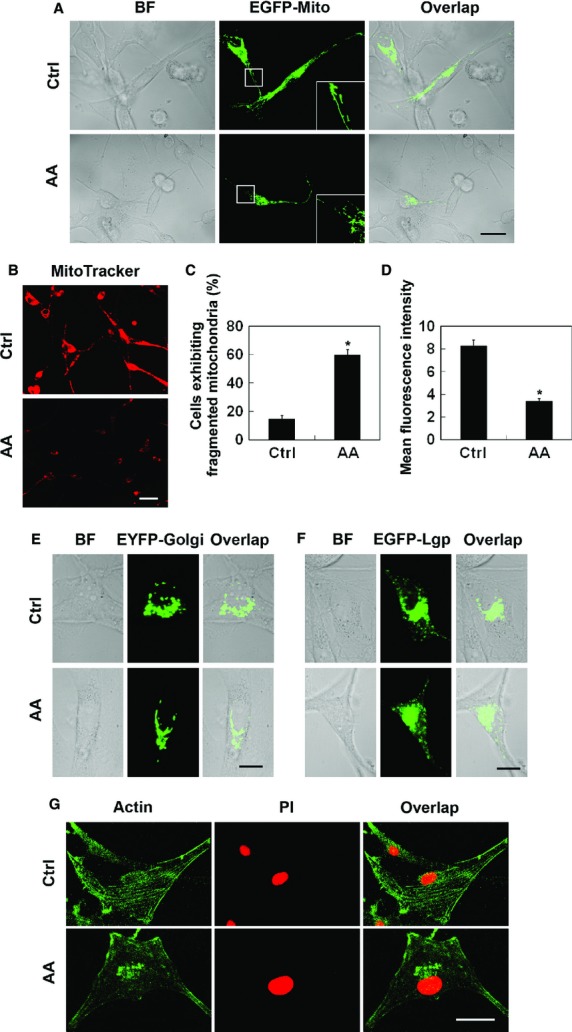
Influence of aurantiamide acetate on intracellular organelles of U87 cells. Cells were transfected with EGFP-Mito (A), EYFP-Golgi (E) or EGFP-Lgp120 (F) to visualize the alternations of mitochondria, Golgi apparatus or lysosomes. Some of the cells were stained with MitoTracker Red (B–D) to determine mitochondrial membrane potential or co-stained with Phalloidin and PI (G) to label F-actin and nucleus respectively. Normal healthy U87 cells (Ctrl) or cells following 48-hrs of 25 μM aurantiamide acetate incubation (AA) were used for analysis of the intracellular organelle alternation. Boxed area in (A) was enlarged in the same figure. BF, bright field. Scale bars in (A), (B) and (G), 20 μm; scale bars in (E) and (F), 10 μm. Quantified data were shown in (C) and (D). Data were calculated from 12 micrographs. *P < 0.05 compared with control.